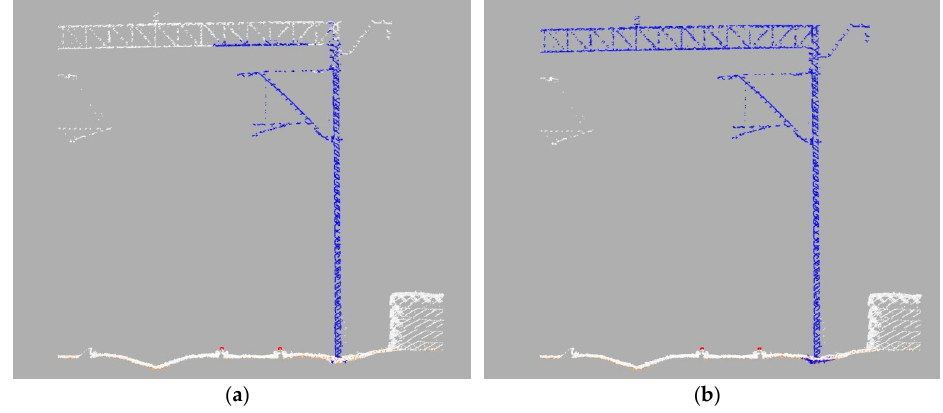
Figure 11. Detected support structure before ( a ) and after ( b ) submission to modified DBSCAN processing. Red, rails, catenary class, blue, unclassified points, white.